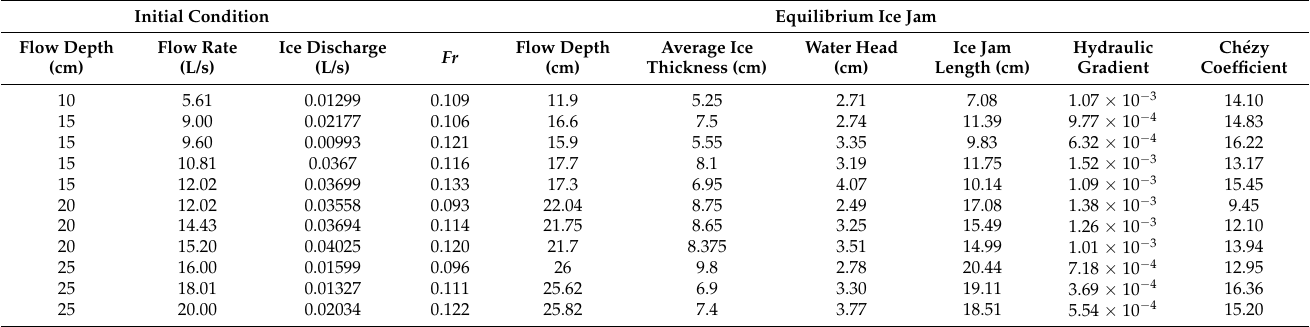
Figure 5. Dependence of flow Froude number Fr on the relative thickness of an ice jam t / H under condition of different H / B. Table 1. Calculated Ch é zy coefficients for 11 experimental